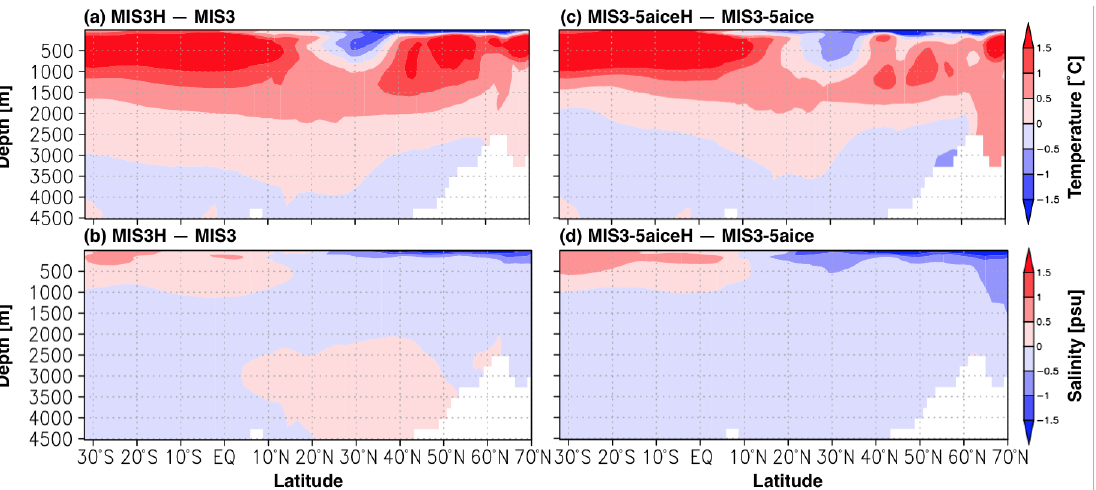
Figure 6. Oceanic responses to freshwater hosing in MIS3 (a, b) and MIS3–5aice (c, d) . Figures on the top show annual mean ocean temperature anomalies ( ◦ C, color), and figures on the bottom show salinity anomaly (psu, color). Differences between the last 100 years of hosing and the last 100 years before hosing are shown.